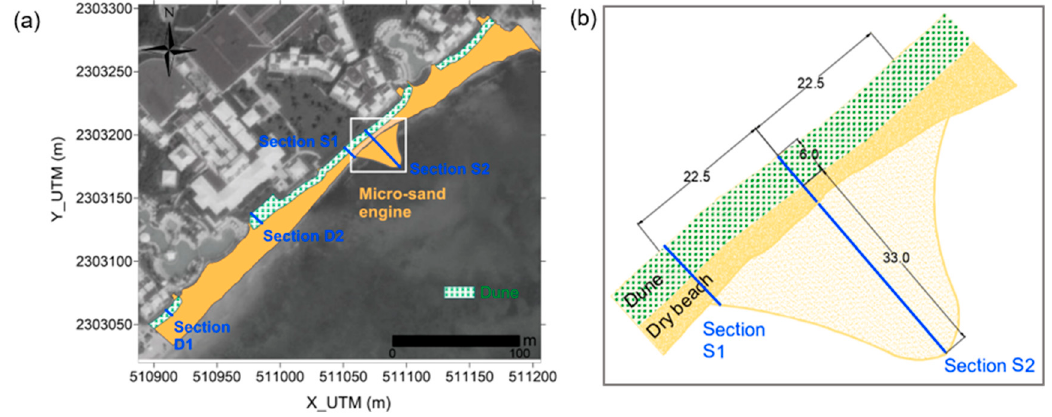
Figure 6. Aerial view of the coastal protection strategy, taking the beach of 26 April, 2017 as a baseline: ( a ) the micro Sand Engine and the dune; ( b ) detail of the micro ‐ Sand Engine shape (dimensions in meters).